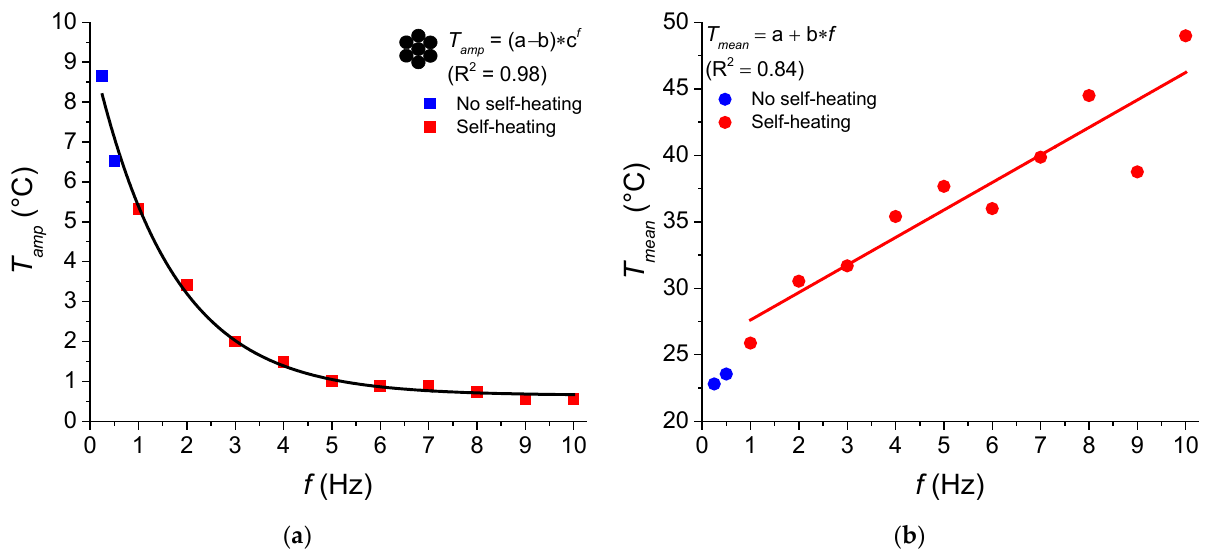
Figure 11. Temperature behavior for the 128th cycle of the NiTi SMA micro cable as a function of loading frequency ( f ). ( a ) Temperature amplitude ( T amp ). ( b ) Mean temperature ( T mean ).